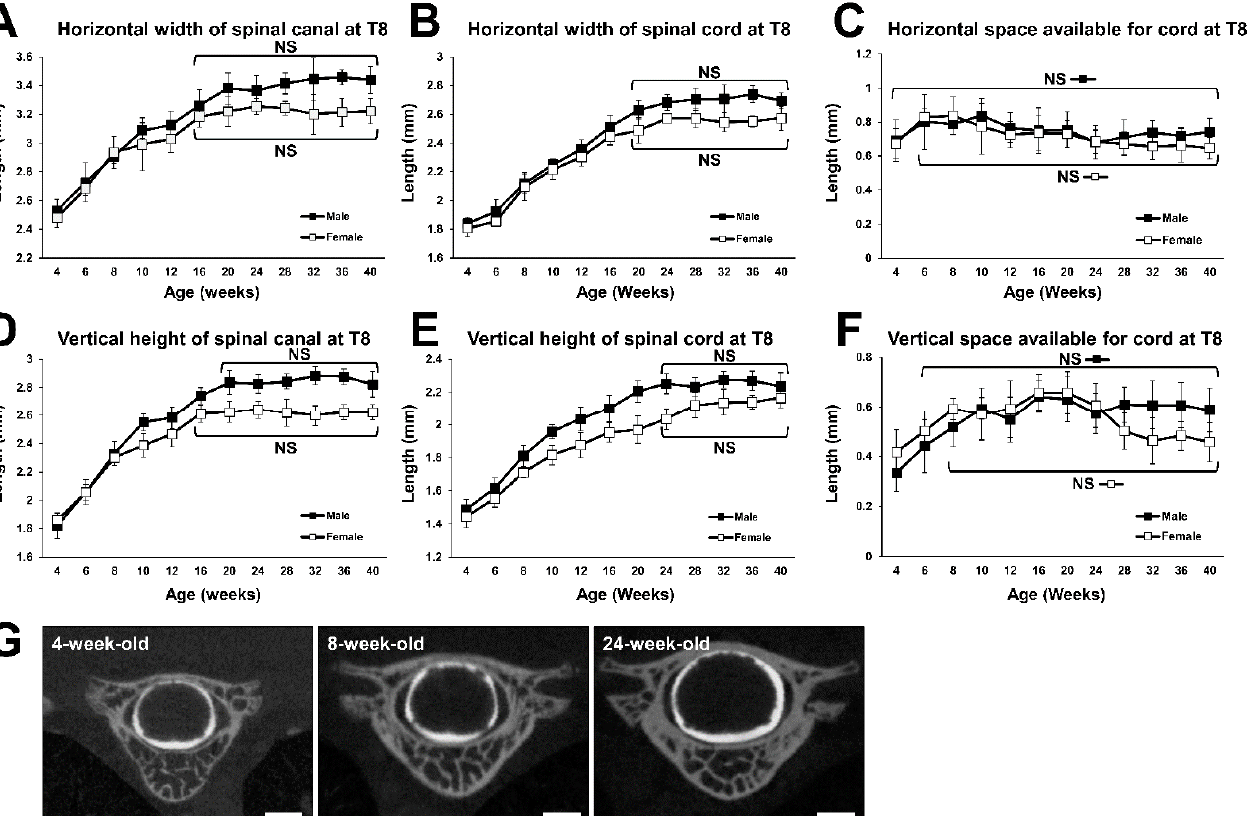
Figure 3. Growth curves for the spinal canal and the spinal cord at T8. ( A ) Growth curve of horizontal width of spinal canal. No statistical difference was detected between the time points at 16 weeks of age and older in males and females. ( B ) Growth curve for the horizontal width of spinal cord. No statistical difference was detected between the time points for 20 weeks of age and older in males and females. ( C ) Growth change of horizontal SAC. No statistical difference was detected in males, and between the time points at 6 weeks of age and older in females. ( D ) Growth curve for the vertical height of the spinal canal. No statistical difference was detected between the time points at 20 weeks of age and older in males, and between the time points at 16 weeks of age and older in females. ( E ) Growth curve for the vertical height of the spinal cord. No statistical difference was detected between the time points at 24 weeks of age and older in males and females. ( F ) Growth change for vertical SAC. No statistical difference was detected between the time points at 6 weeks of age and older in males, and between the time points for 8 weeks of age and older in females. ( G ) Representative coronal CTM images of T8 spinal segment of a 4-, 8-, and 24-week-old female. Scale bars, 1